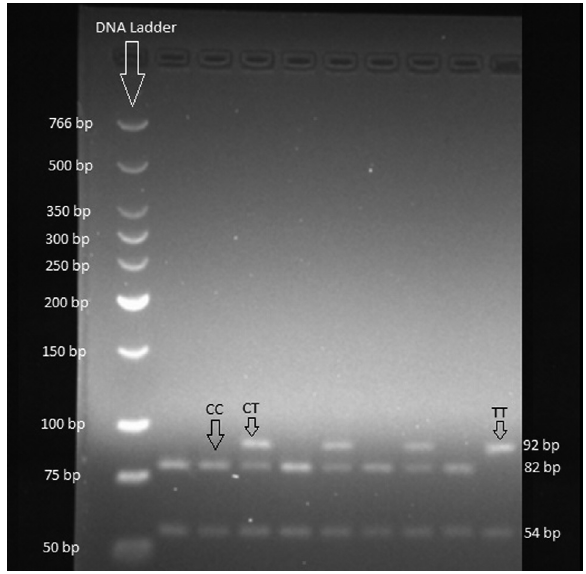
Figure 2 - The actual restriction pattern of the PCR product for CHRNA3 rs578776 by using Nla